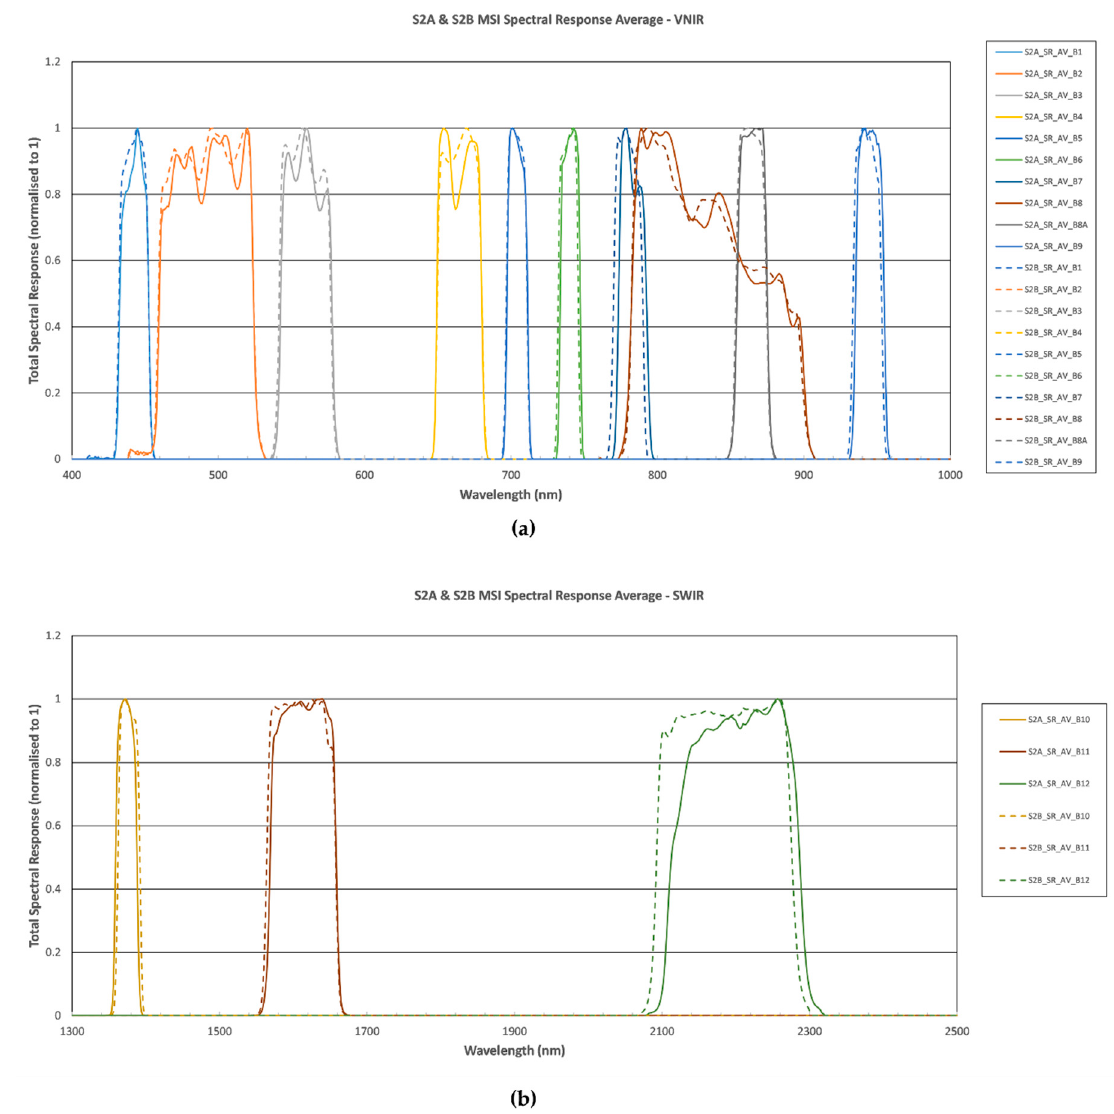
Figure 1. Sentinel-2 bands and their spectral sampling intervals for VNIR (400–1000 nm) and SWIR (1000–2500 nm) [21] .